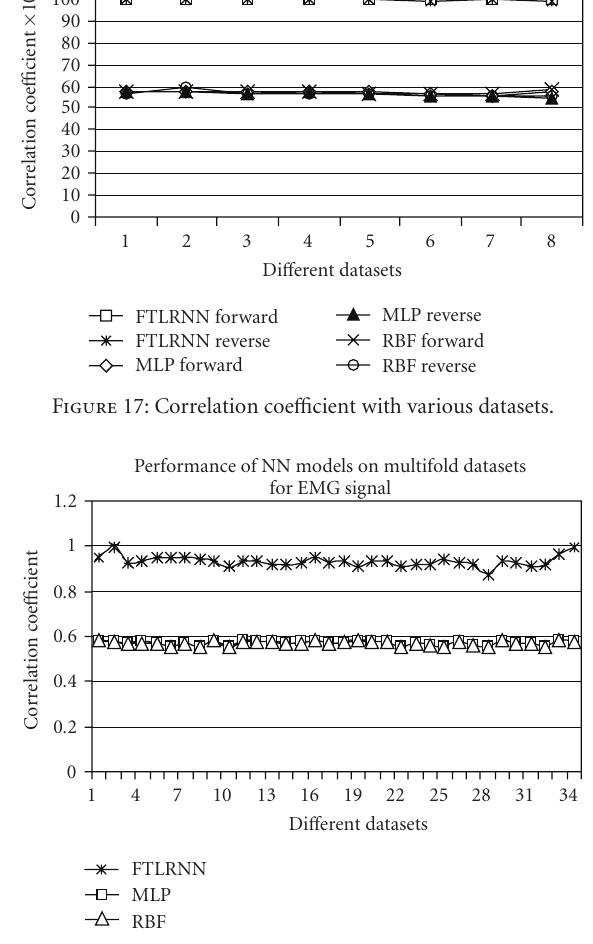
FTLRNN with only one hidden layer having architecture (1-27-2) is able to remove noise with reasonable